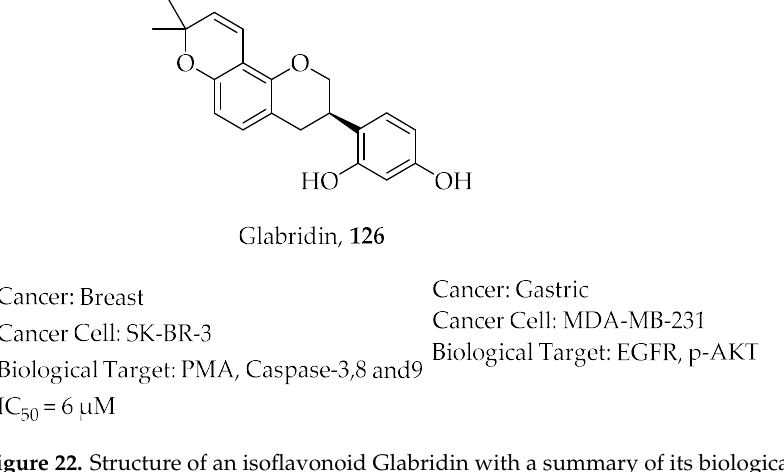
Figure 23. Structures of the flavonoid glycoside Isoliquiritin and its biosynthesized derivative isoliquiritin apioside with a summary of their biological activity towards selected cancer targets. An isolate from Glycyrrhiza uralensis, Licoricidin, 129 is another prenylated isoflavo- noid that has been found to inhibit SW480 cells (IC 50 7.2 μM) by inducing cycle arrest, apoptosis, and autophagy. It exhibits a range of biological activities including antibacte- rial, anti-aging, and anticancer activities. It is a potential chemopreventive or chemother- apeutic agent against colorectal cancer (Figure 24) [177]. Compound 129 exhibits its anti- carcinogenic effects by inhibiting lung metastasis via suppression of tumor angiogenesis and lymphangiogenesis as well as changing in the local microenvironment of the tumor tissues [178]. It also enhances enhanced gemcitabine-induced cytotoxicity in Osteosar- coma (OS) cells through inactivation of the Akt and NF-κB pathways [179]. The com- pound also blocks UVA-induced photoaging via ROS scavenging and limits the activity of MMP-1 [180].